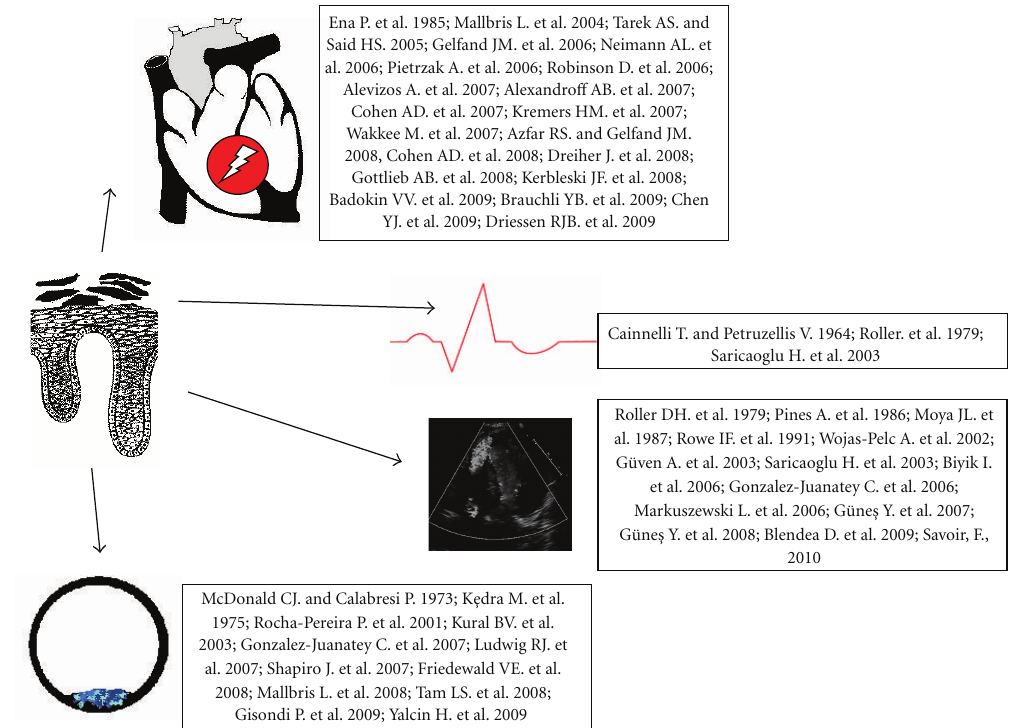
Figure 4: Psoriasis and cardiovascular abnormalities. This figure is a modified one (after permission) from [19].